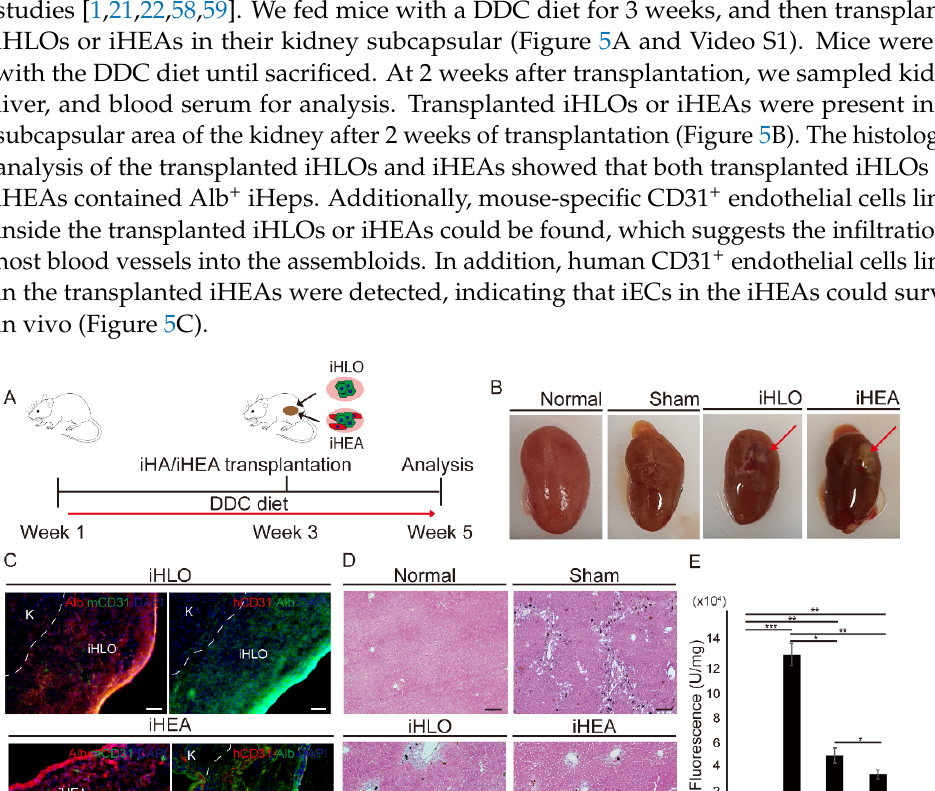
Figure 5. Transplantation of iHLOs and iHEAs in DDC-induced cholestatic liver fibrosis model. ( A ) Schematic overview of experiments analysis of the effect of iHLOs and iHEAs in DDC4-induced cholestatic liver fibrosis model. ( B ) iHLOs and iHEAs in kidney subcapsular region 2 weeks after